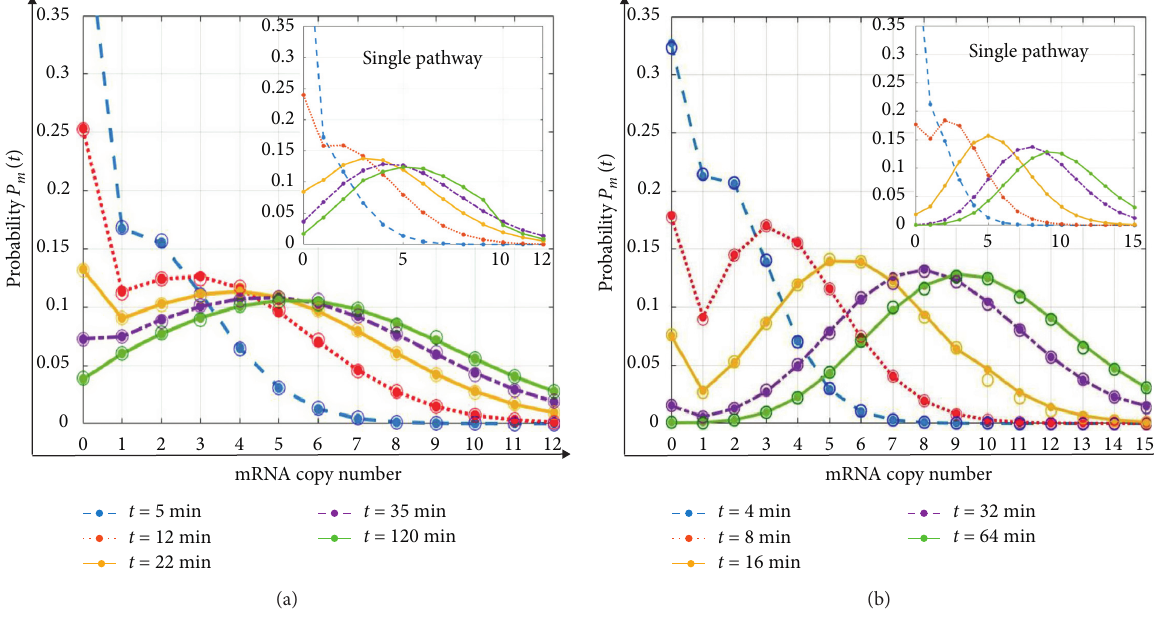
Figure 1: Cross-talking pathways generate typical dynamical transitions from mRNA decaying distribution to unimodal distribution undergoing the significant intermediate bimodal stage for stress genes in yeast with v � 0 . 63 , δ � 0 . 063 , λ Dynamical distribution of the stress gene under mild stress level equipped with q dynamics of the stress gene under high stress level with q analytical solution, whereas the hollow circles represent the numerical result obtained by Gillespie’s algorithm. The embedded distribution dynamics are generated by the single pathway in which durations of bimodal distribution are much shorter than that generated by cross- talking